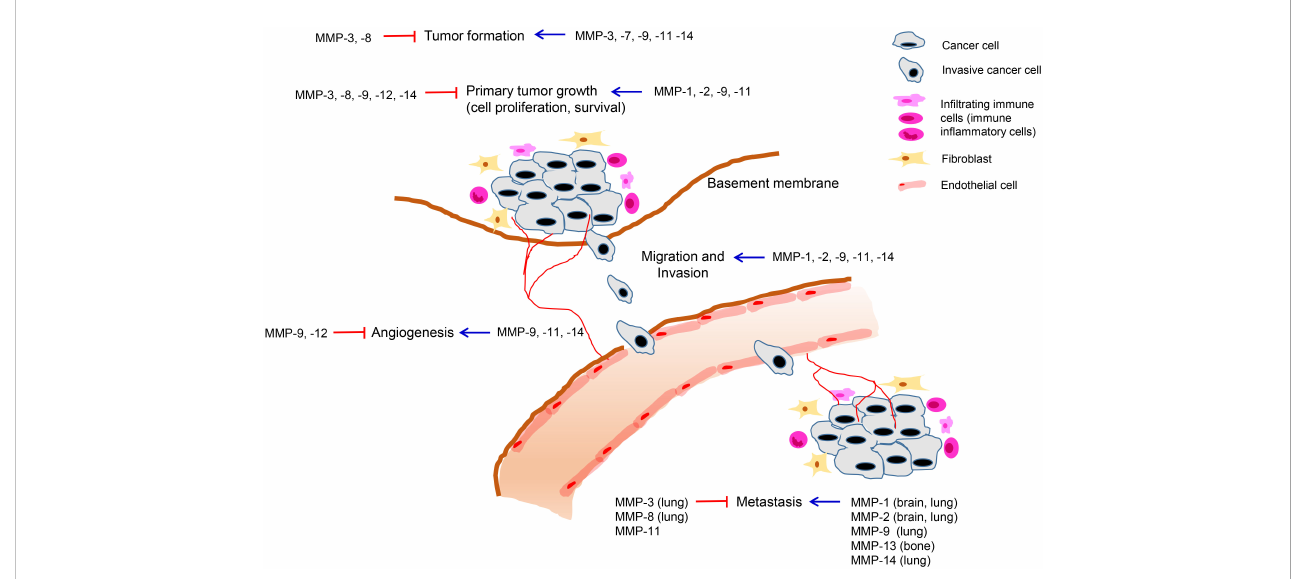
FIGURE 1 Roles of MMPs in breast cancer development and progression. MMPs are expressed in various cell types including tumor cells and neighboring stromal cells, such as fi broblasts, immune cells, and endothelial cells comprising the tumor microenvironment. Tumoral or stromal MMPs play roles in multiple stages of breast cancer progression including primary tumor growth, angiogenesis, invasion, and metastasis. MMPs can exert pro-tumorigenic or anti- tumorigenic functions in breast cancer and the same MMP can exhibit opposing roles depending on stage of cancer